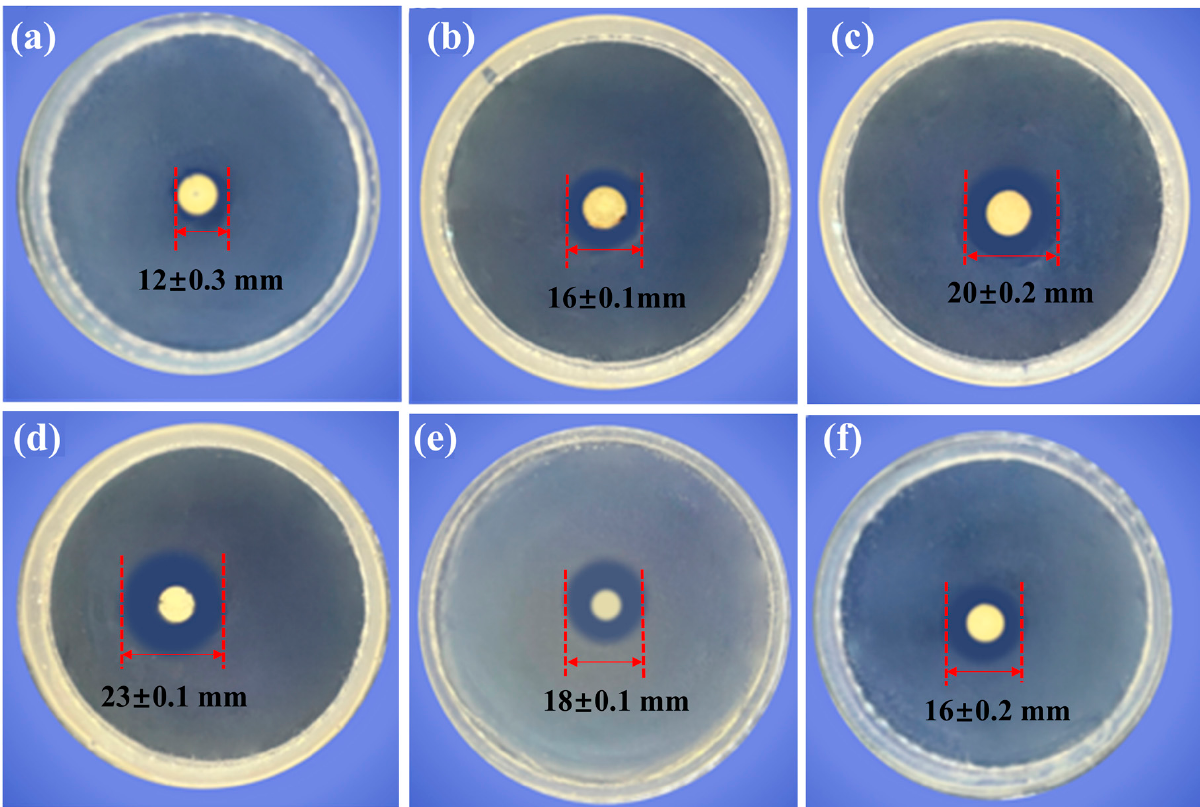
Figure 6. The images of inhibition zones for di ff erent samples against E. coli . ( a ) OCN, ( b ) CS-OCN-